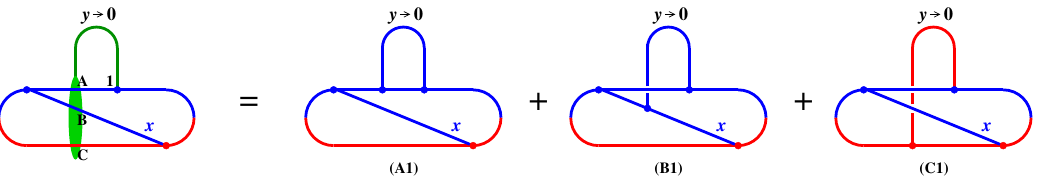
Figure 24 . An example A1 + B1 + C1 of three diagrams whose leading small- y behaviors do not